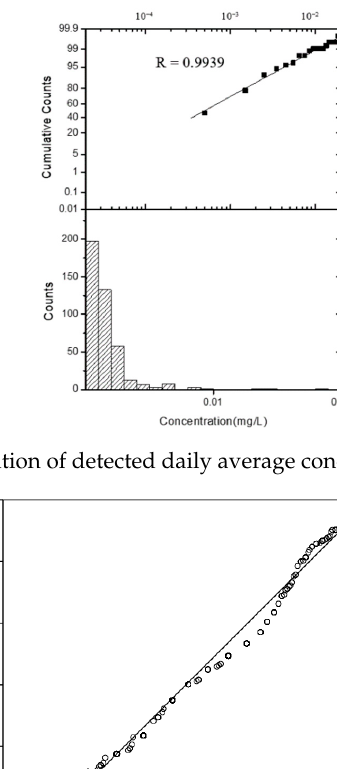
Figure 2. Statistical distribution of detected daily average concentrations of Hg of the WWTPs.